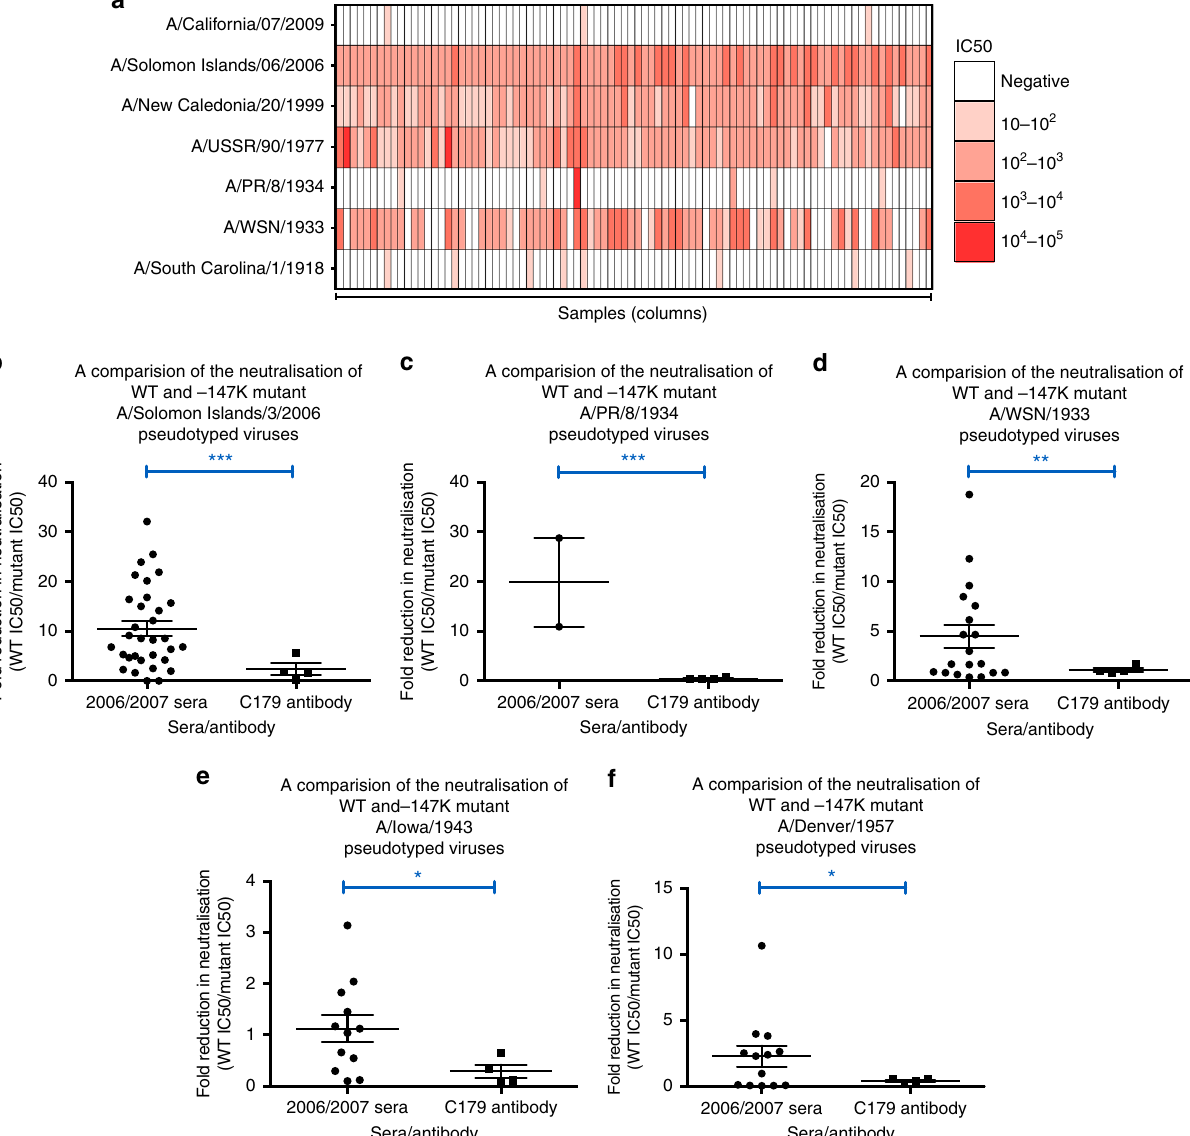
Fig. 1 Pseudotype microneutralisation data reveals a cyclic pattern of epitope recognition. a Serum samples from children aged between 6 and 12 years in 2006/2007. n = 88 were tested for their ability to neutralise a panel of pseudotyped lentiviruses representing a range of historical isolates. b – f A lysine residue was inserted at position 147 linear numbering, where Met = 1 through site-directed mutagenesis SDM in the HAs of pseudotyped lentiviruses A/ WSN/1933, A/PR/8/1934 and A/Solomon Islands/3/2006 included in panel A as well as A/Iowa/1943 and A/Denver/1957. The ratio of WT IC50 to mutant IC50 was then assessed to determine if there was reduction in neutralisation. A stalk-targeting antibody, C179, was used as a control. The values provided are an average of two replicates. Student ’ s t tests were used to determine all p -values: *** p -value < 0.001, ** p -value< 0.010 and * p -value < 0.050. Error bars are mean ±